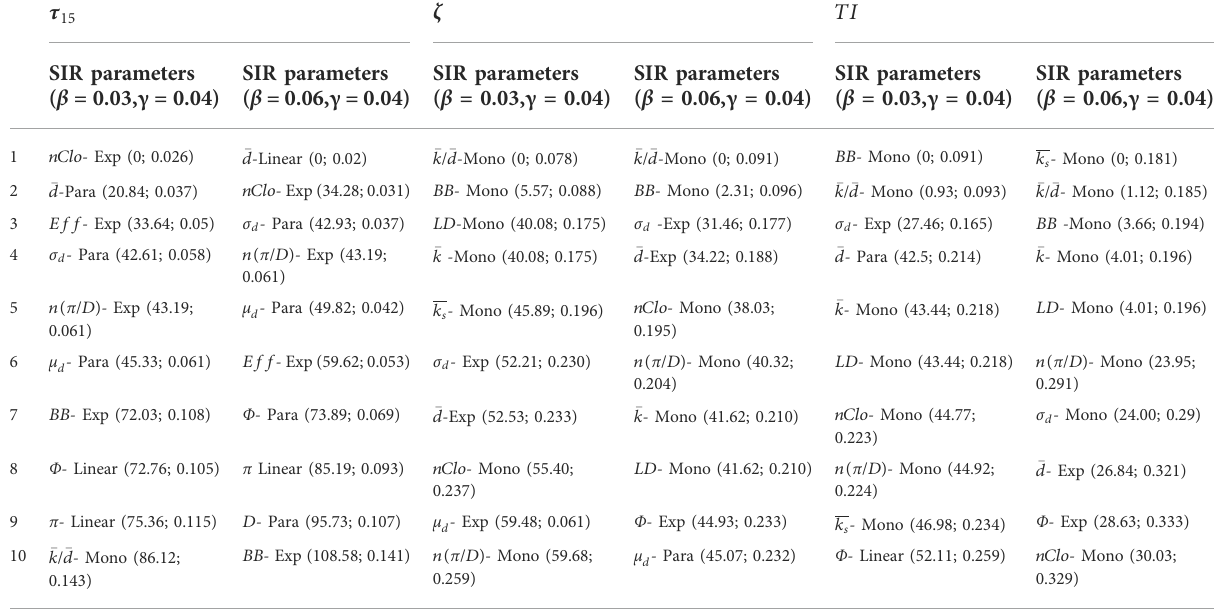
TABLE 1 The best ten NSIs to predict epidemic spreading for each spreading